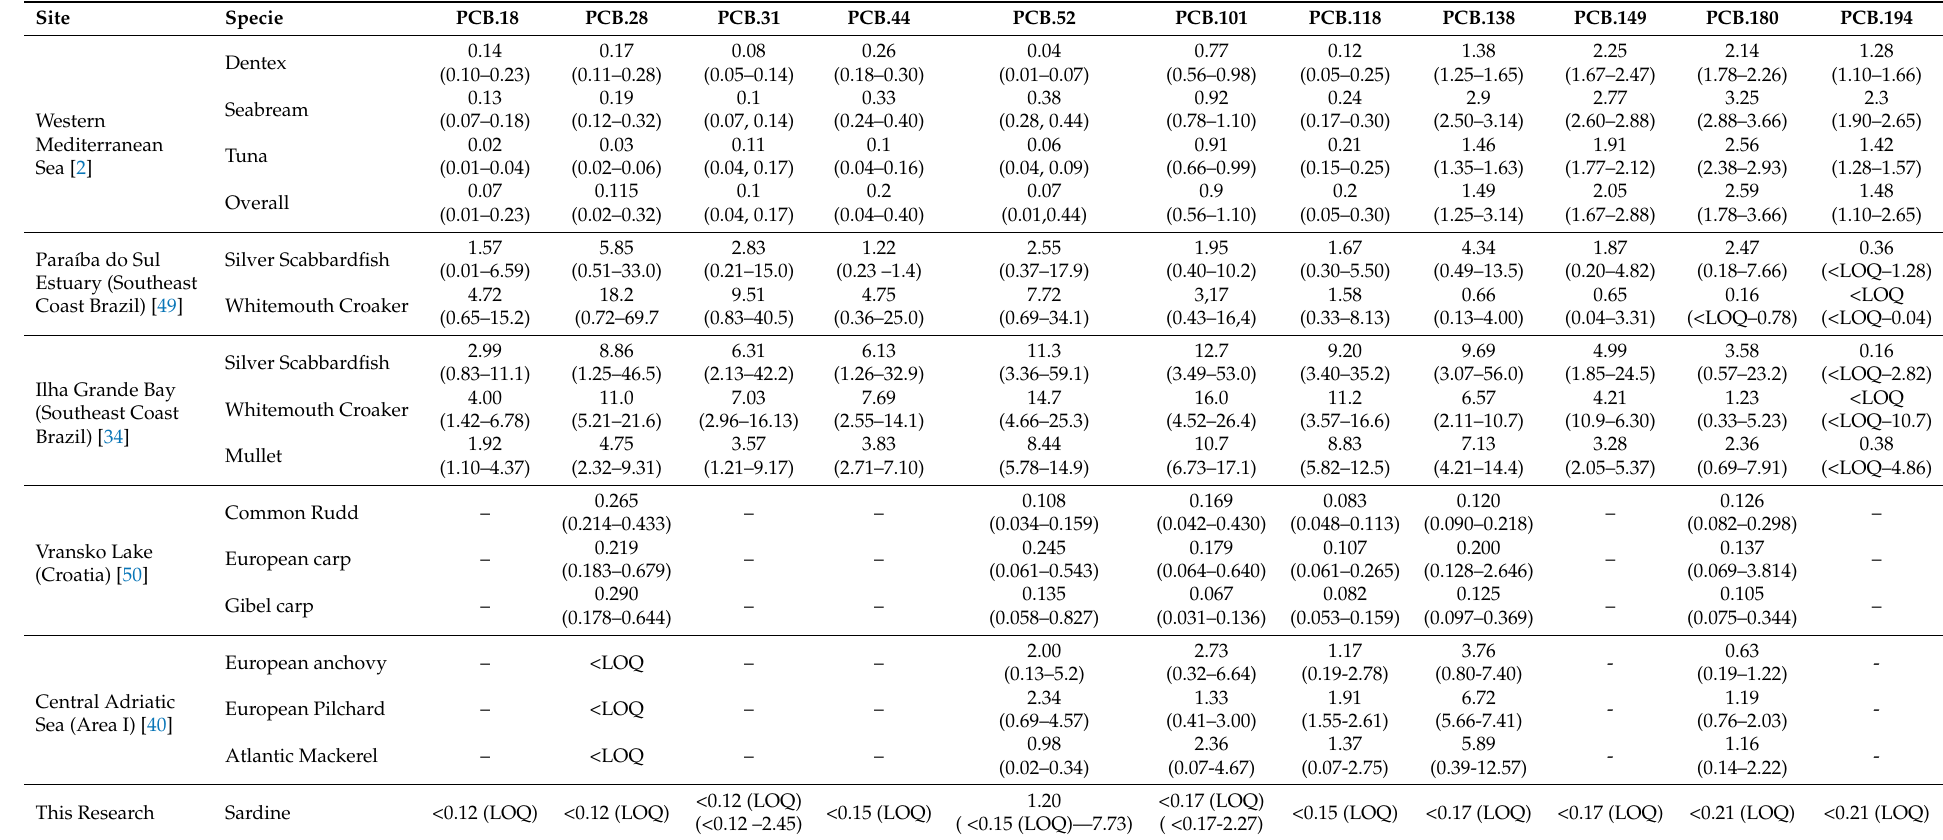
Table 4. PCB concentration (muscle tissue ) in Brazilian and global sites. Concentration in ng g − 1 wet